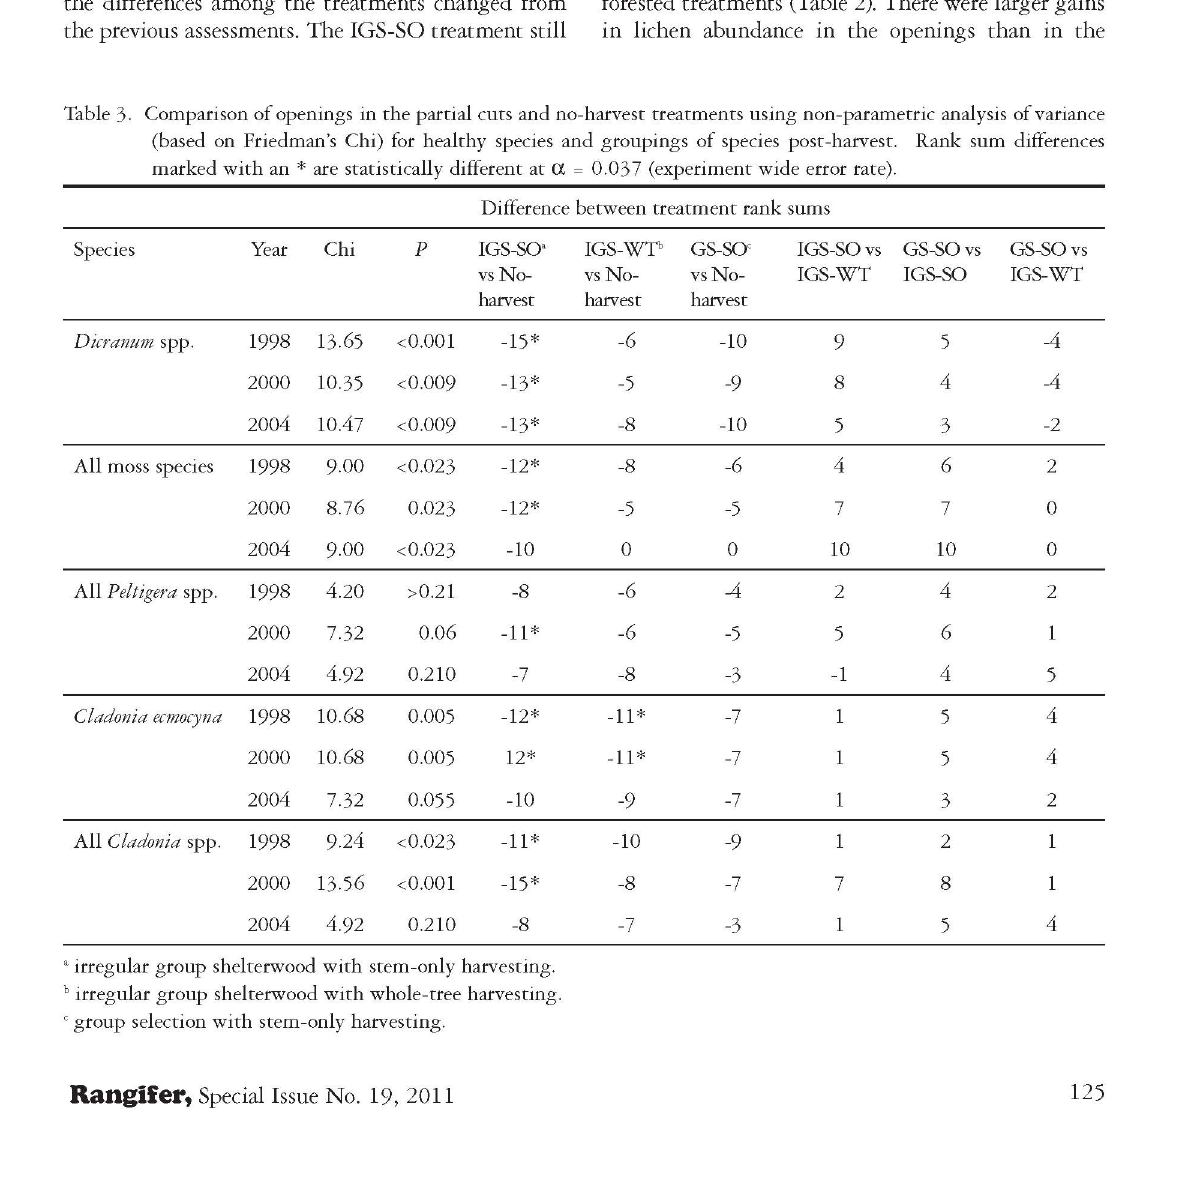
Table 3- Comparison of openings in the partial cuts and no-harvest treatments using non-parametric analysis of variance (based on Friedman's Chi) for healthy species and groupings of species post-harvest- Rank sum differences marked with an * are statistically different at a = 0-037 (experiment wide error